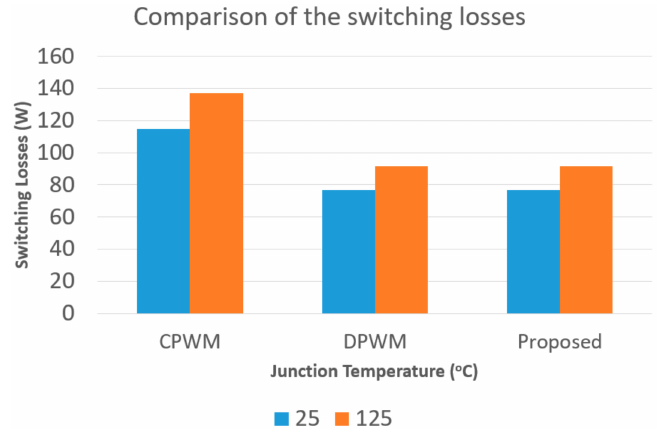
Figure 8. Switching losses of the CPWM, DPWM and the proposed method at junction temperatures 25 and 125 ◦